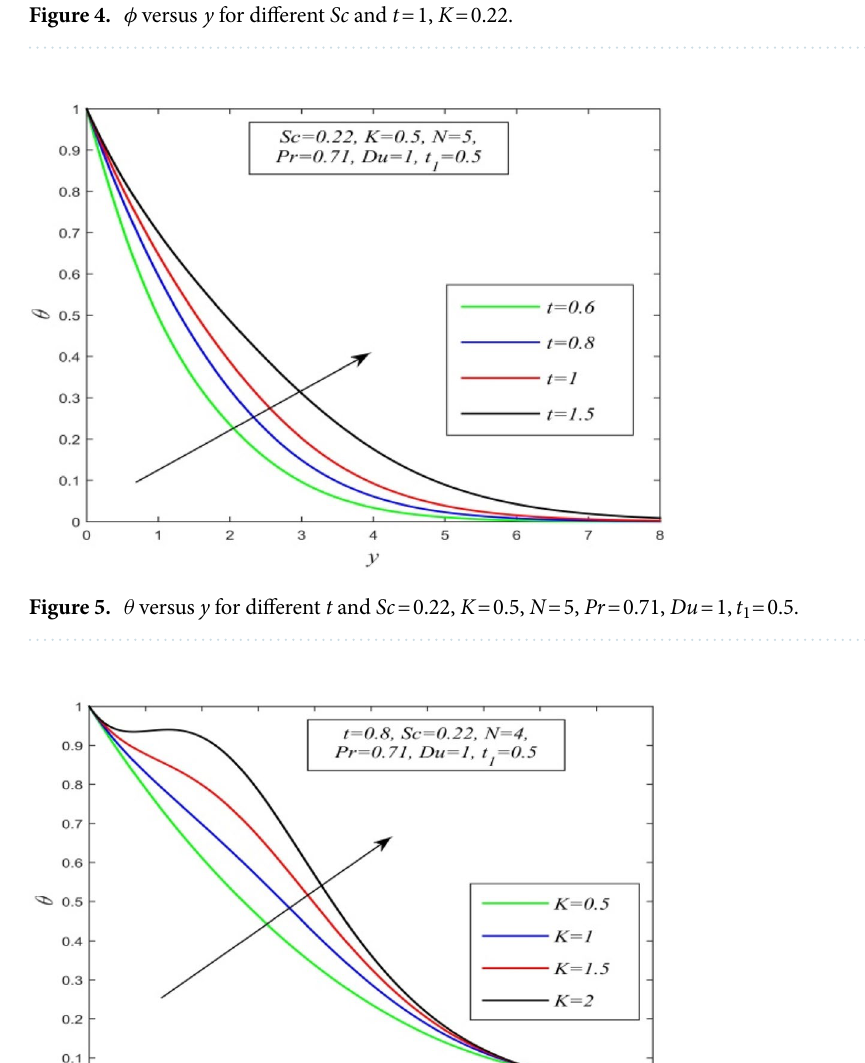
Figure 4. φ versus y for different Sc and t = 1, K = 0.22.